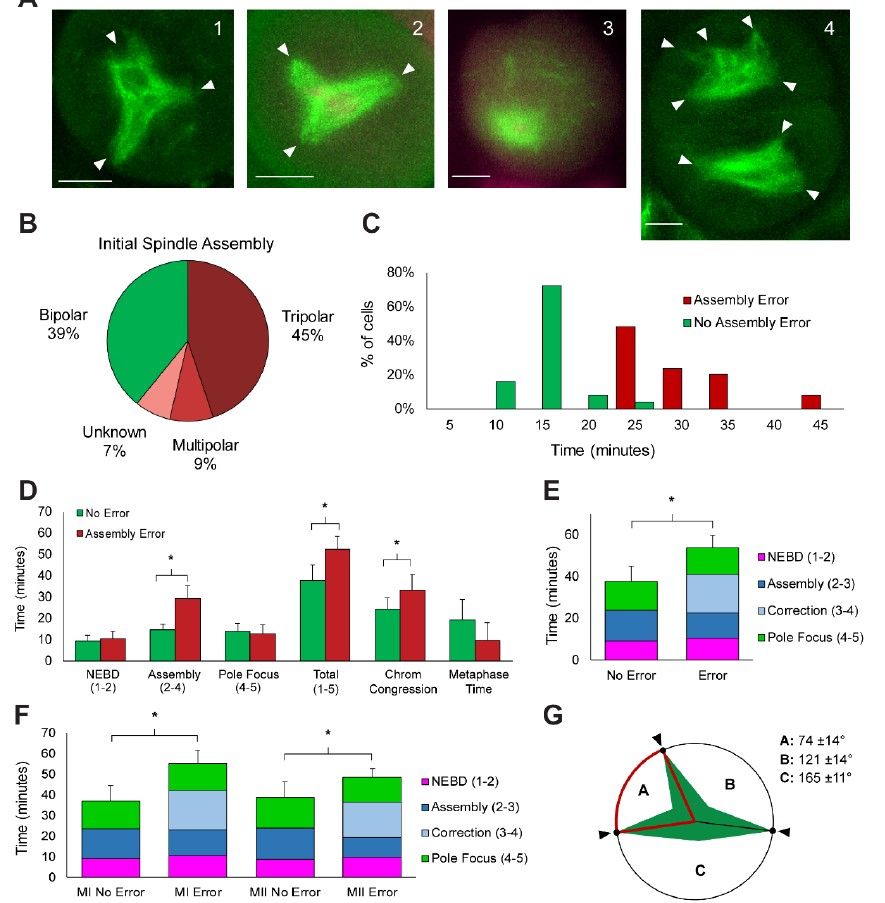
Figure 6. Characterization of spindle assembly errors and correction dynamics. ( A ) Examples of incorrect spindle morphology in meiosis I (panel 1–3) and meiosis II (panel 4): tripolar spindles (panel 1, 2, bottom cell in panel 4), unknown polarity (panel 3), and multipolar (top cell in panel 4). White arrows indicate poles. Scale bars: 10 µm. ( B ) Distribution of initial spindle morphologies: bipolar spindles (green) form only 39% of the time ( n = 27/70), and the remaining assemblies contain errors (red), the most frequent being tripolar ( n = 32/70). ( C ) Histogram of spindle assembly time; same data as Figure 2C but categorized by errors in assembly revealing two distinction populations. ( D ) Comparison of assembly dynamic parameters by error status. * denotes p -value < 0.001, t -test ( E ) Total assembly time in error and no error cells; breakdown by stage: NEBD (pink), initial assembly (dark blue), correction time (light blue), and pole focus (green). Error bars represent standard deviation. * denotes p -value < 0.001, t -test ( F ) Same stage breakdown analysis as displayed in ( E ) but separated by each population: meiosis I no error, meiosis I error, meiosis II no error, meiosis II error. * denotes p -value < 0.05, t -test ( G ) Correction of tripolar spindles by fusion of poles (black arrow). Fusion always occurred between poles separated by the smallest angle (A); average angle measurements